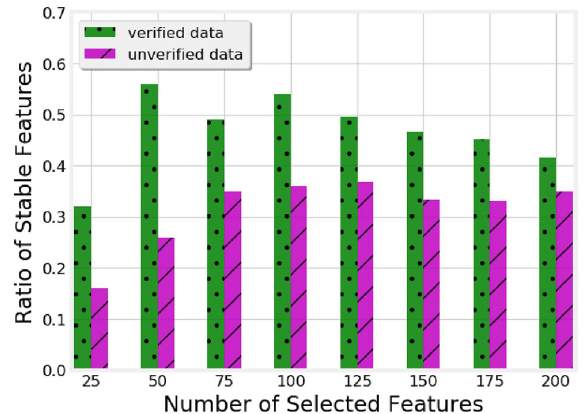
Figure 3. Ratio of stable features among the features selected by models trained on verified and unverified data.